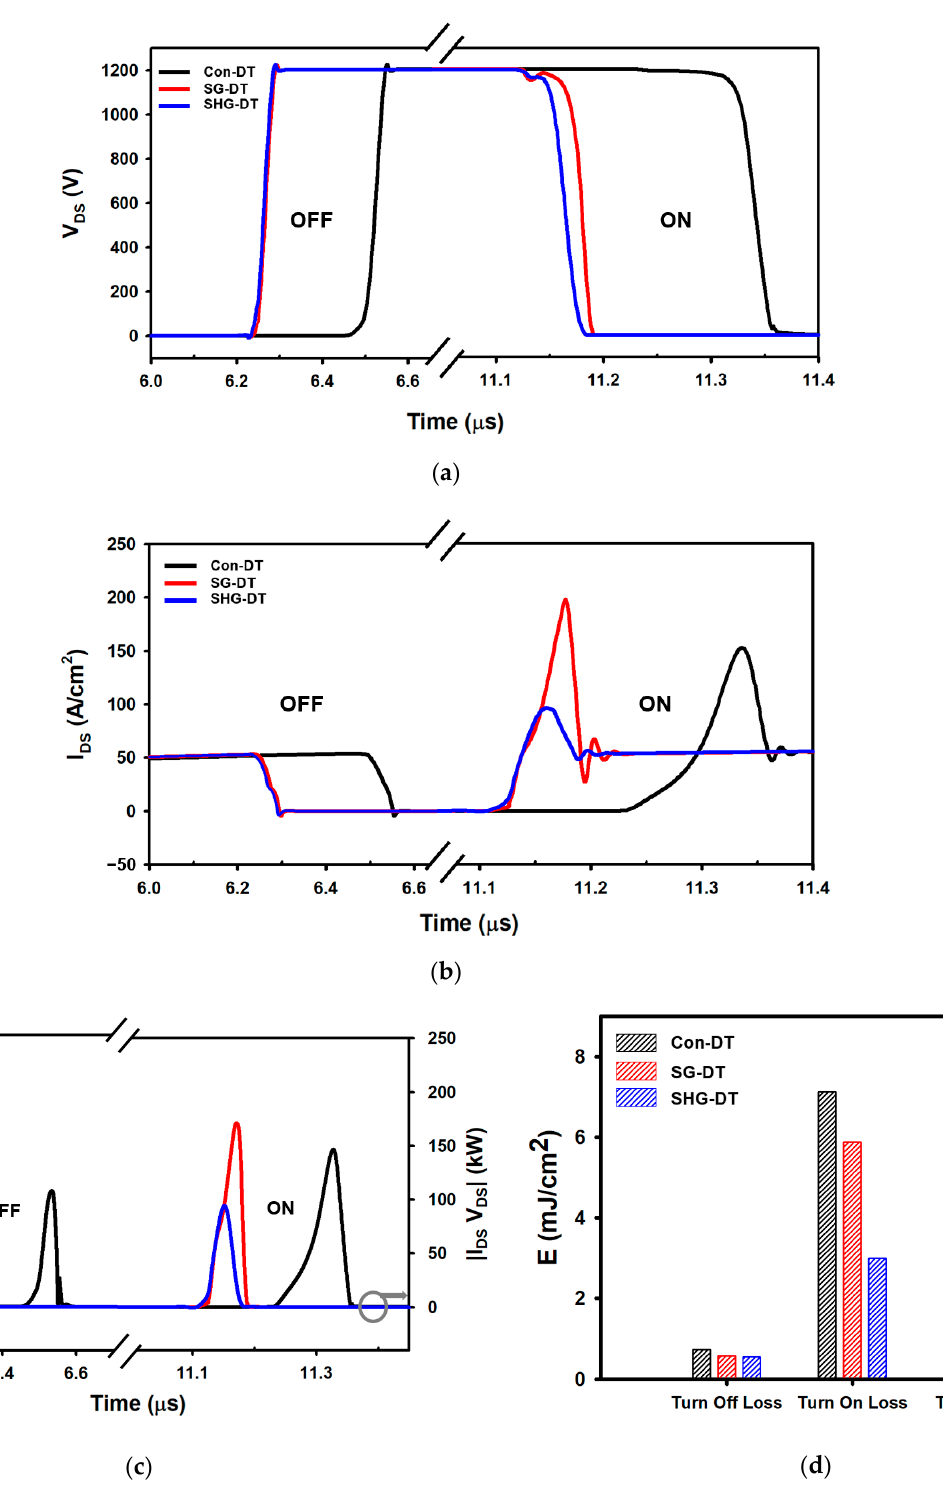
Figure 8. Comparison of Con-DTMOS, SG-DTMOS, and SHG-DTMOS of ( a ), ( b ) switching characteristics, ( c ) power consumption, and ( d ) switching loss. Table 3. Body diode and switching characteristics of each devices.